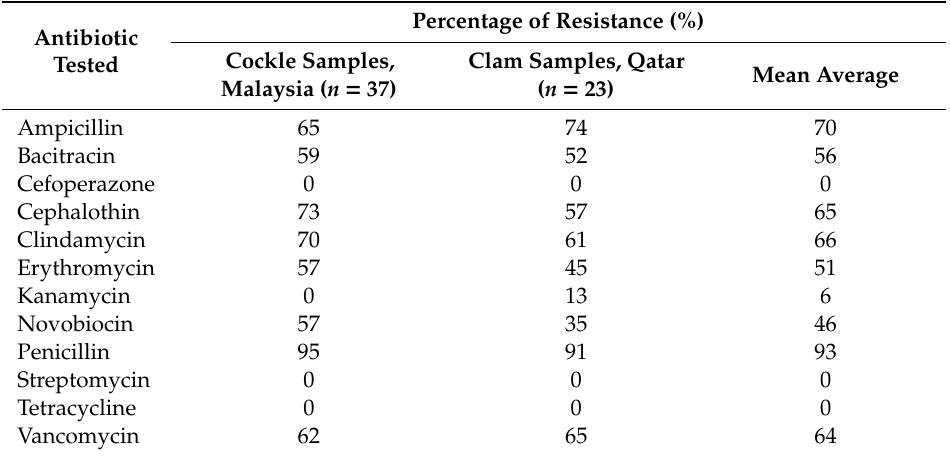
Table 1. Frequency of antibiotic resistance Vibrio vulnificus isolates from cockle and clam samples. Antibiotic